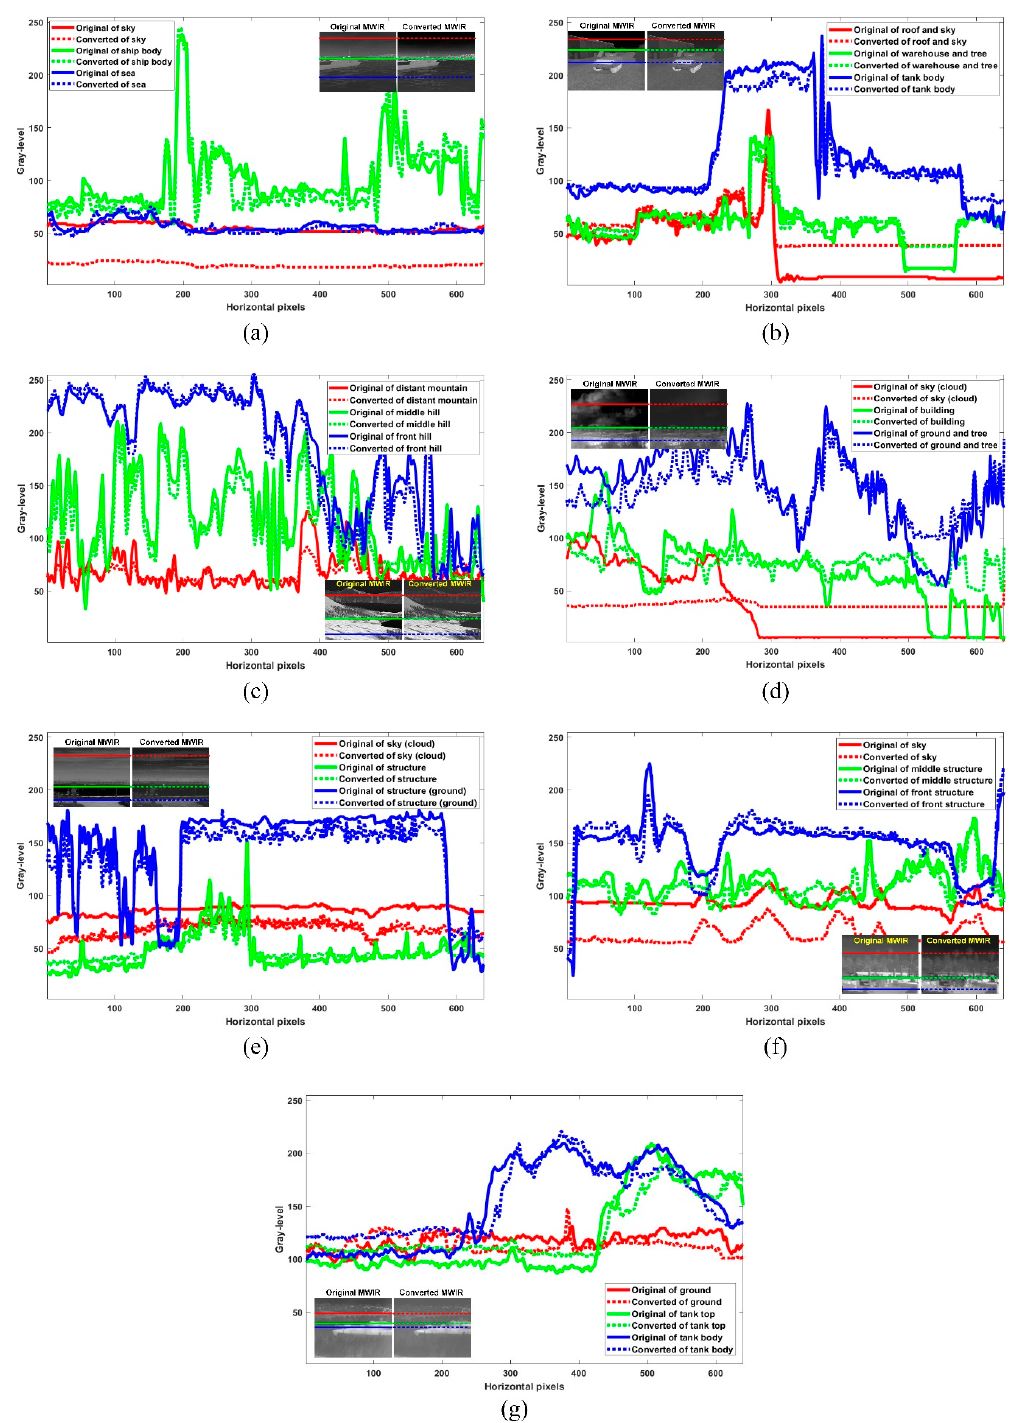
Figure 13. Pixel values of red, green, and blue lines on original MWIR images and converted MWIR image for test images, ( a ) SHIP, ( b ) TANK, ( c ) MOUNTAIN, ( d ) BUILDING, ( e ) AIRPORT, ( f ) GROUND, and ( g ) TANK2.